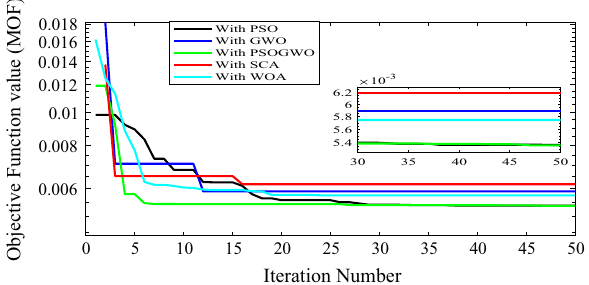
Figure 8. Convergence curve for 3-DG integration with different